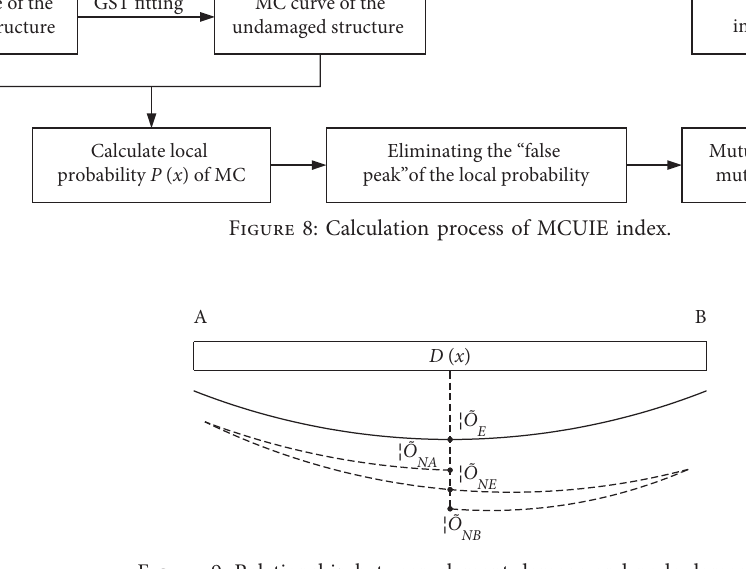
Figure 9: Relationship between element damage and node damage.